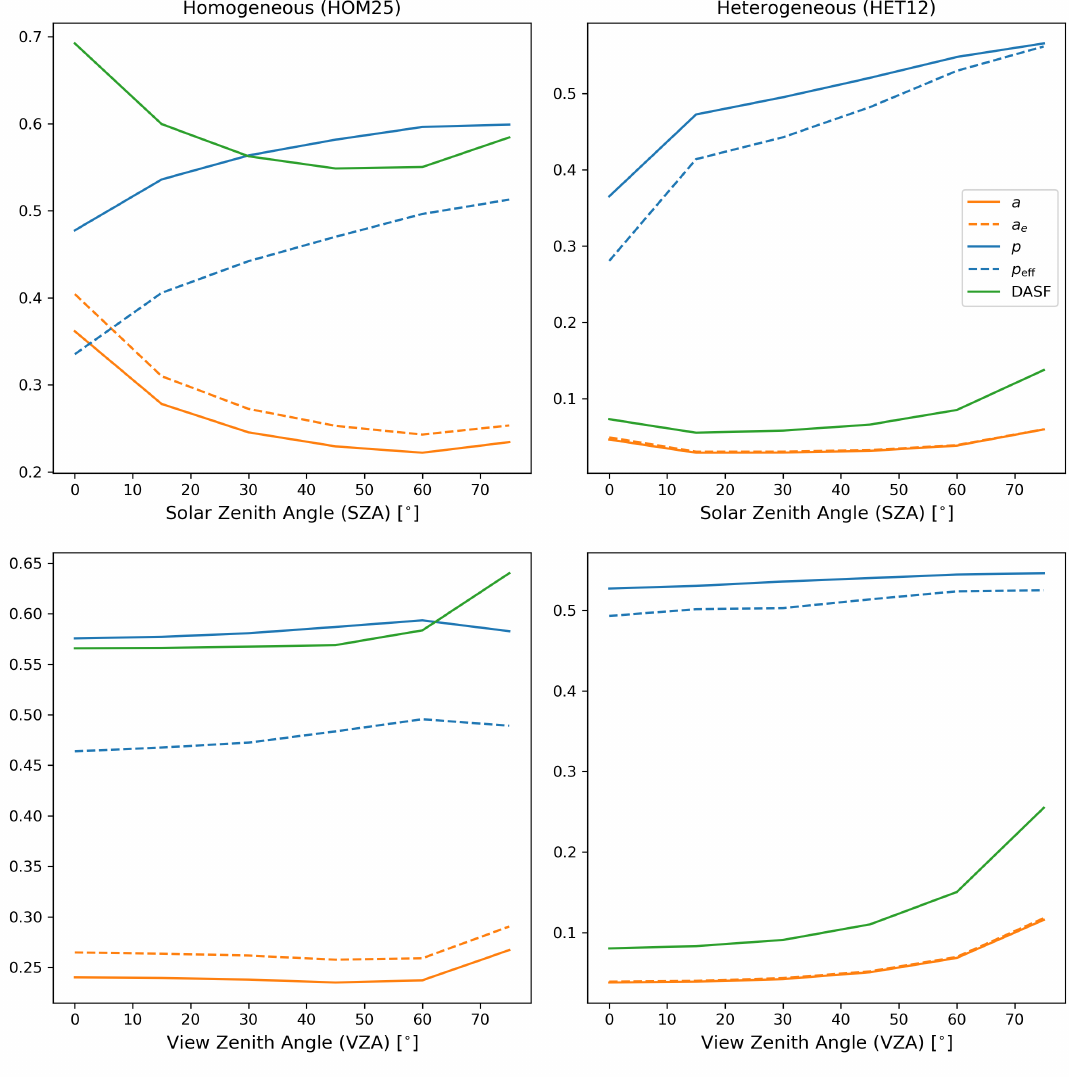
Figure 5. Dependence of a , p and DASF with Solar Zenith Angle (SZA) ( top panels ) and View Zenith Angle (VZA) ( bottom panels ) for homogeneous ( left panels ) and heterogeneous ( right panels ) canopies. VZA predominantly influences a , whereas p depends weakly on VZA. Smolander and Stenberg